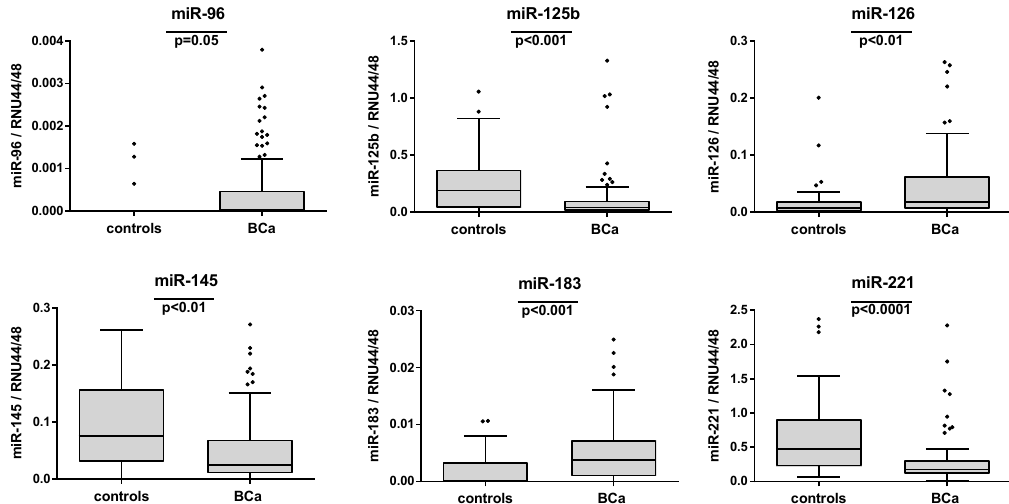
Figure 2. The distribution of the relative expression levels of the significantly altered miRNAs in urine sediments from controls and BCa patients is presented by box plots. Differences in the relative expression levels of the miRNAs (normalized to the geometric mean of the reference RNAs RNU44 and RNU48) were assessed using the Mann–Whitney U test followed by Bonferroni’s correction for multiple comparisons.